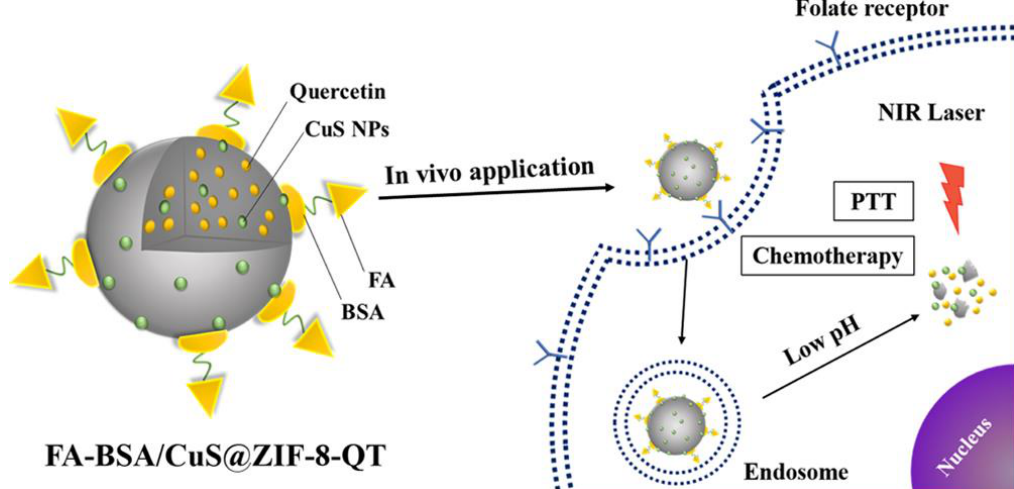
Figure 4. Schematic illustration of the combinational therapy platform based on folic acid (FA) − bovine serum albumin (BSA)-modified ZIF-8 (FA − BSA / CuS@ZIF-8-QT) [90]. Reprinted (adapted) with permission from (CuS@MOF-Based Well-Designed Quercetin Delivery System for Chemo–Photothermal Therapy). Copyright (2018) American Chemical Society.